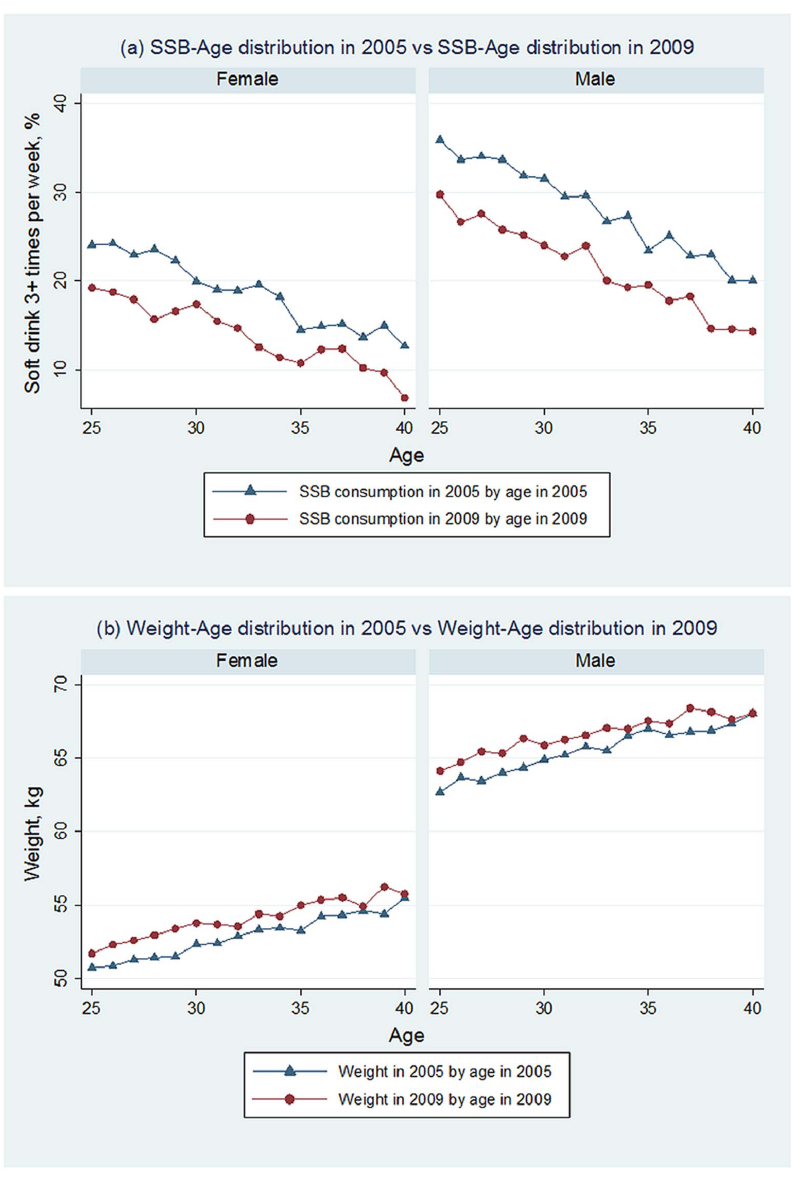
Figure 1. SSB and age and age-weight distribution in 2005 and 2009.